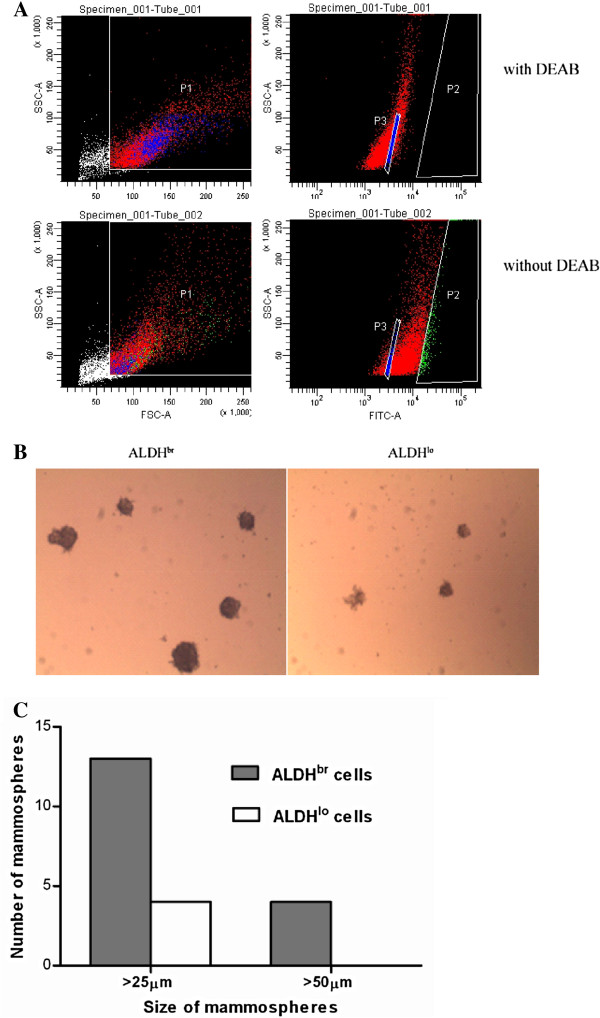
4T1 ALDHbr cells have high mammosphere-forming ability. (A) Representative flow cytometry plots demonstrating the sorting of 4T1 cells with high (ALDHbr, P2, 3~5% of P1 gate) and low ALDH activity (ALDHlo, P3, 3~5% of P1 gate). The first gate (P1) chooses the cells with good status from the total cells and excludes cell debris according to their FSC & SSC values. The cells were incubated with an aldefluor substrate (BAAA), and the specific inhibitor of ALDH, DEAB, was first used to establish the baseline fluorescence level of ALDH activity (top). Staining of 4T1 cells with aldefluor substrate but without DEAB inhibitor produced a shift in BAAA fluorescence that defined the ALDHbr population (bottom). (B) ALDHbr (left) and ALDHlo (right) cells were plated for mammosphere formation (5 × 104 cells/well) for 8 days. Mammospheres were observed using an Olympus inverted phase contrast microscope (40 × objective magnifications). (C) The data shown are the average number of spheres counted in different sizes from a representative experiment performed in duplicate wells.